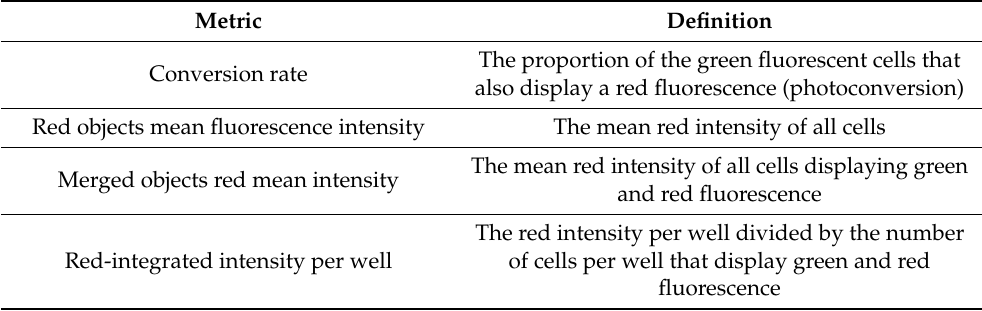
Table 2. Photoconversion